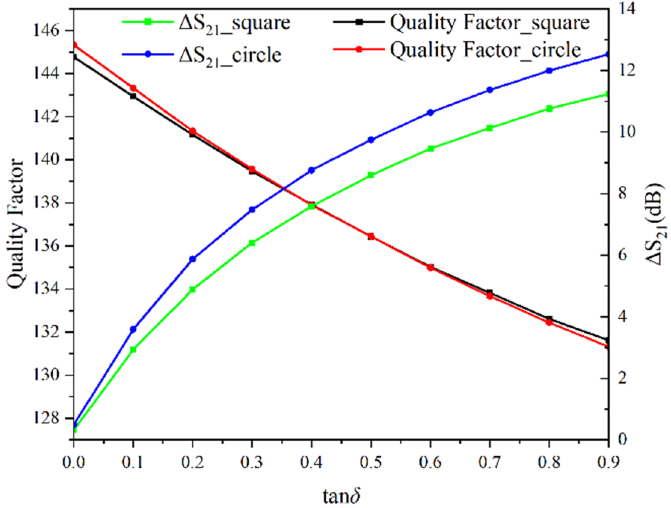
Figure 6. Variation of quality factor versus loss tangent for